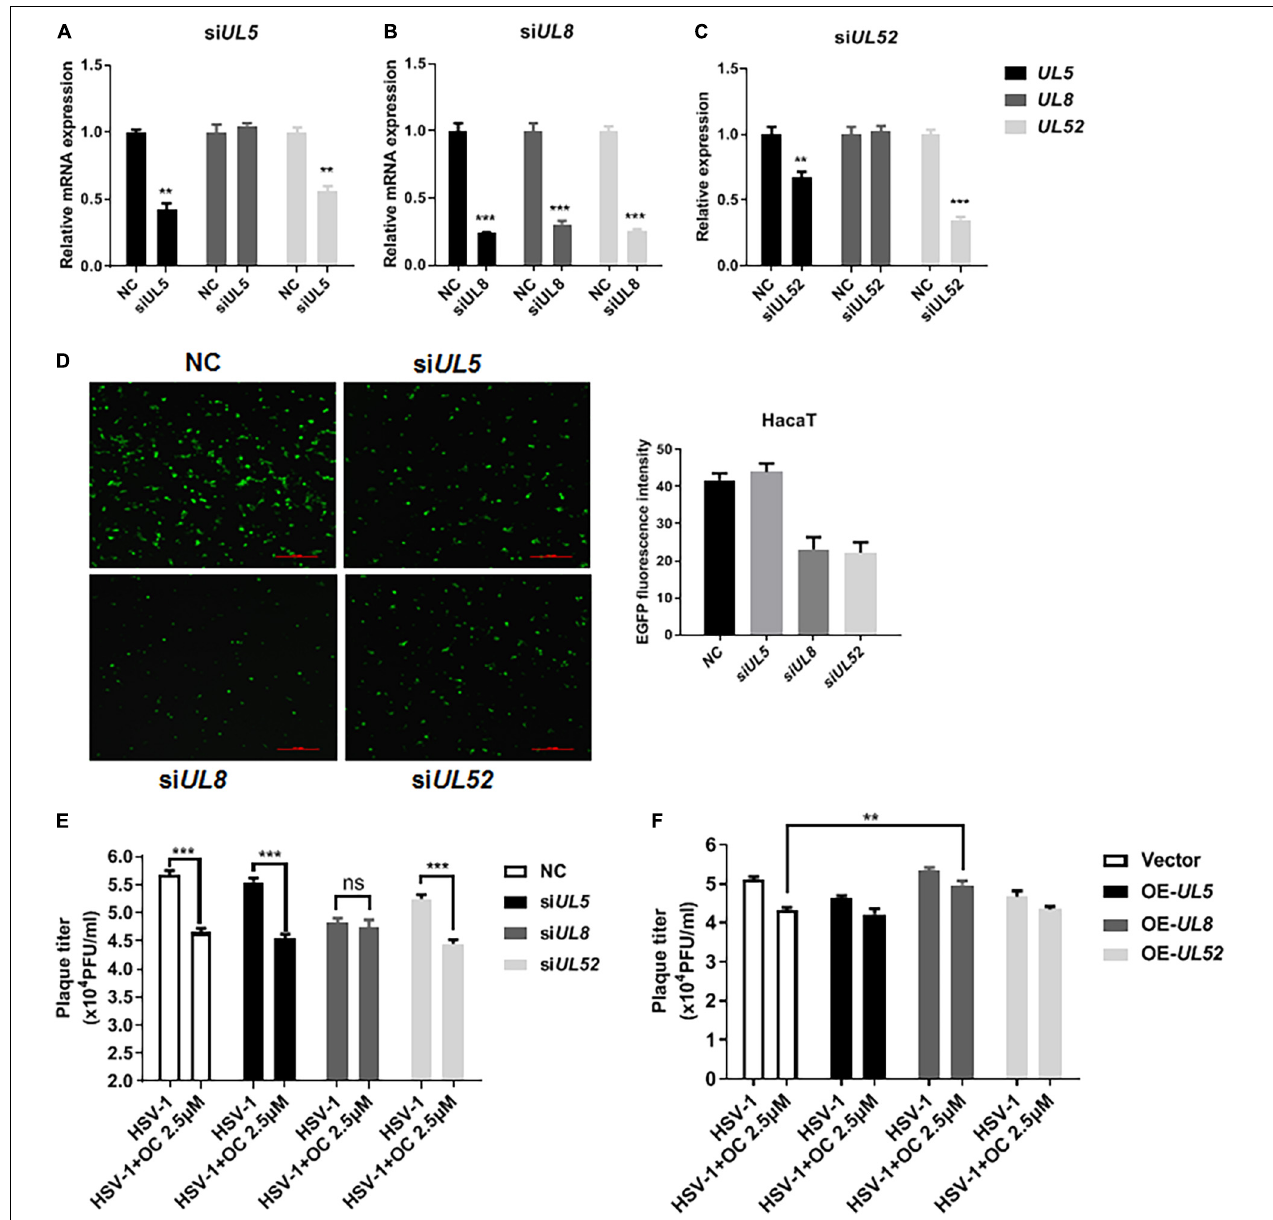
FIGURE 5 | UL8 is involved in the antiviral action of Oleanolic acid. (A–C) HaCaT cells were firstly infected with HSV-1 (MOI = 1) for 2 h and were then transfected with siRNAs targeting UL5 , UL8, and UL52 , respectively. After 24 h incubation, total RNA was extracted and the mRNA expressions of UL5 , UL8, and UL52 were detected by qRT-PCR. (D) HaCaT cells were infected with the EGFP-HSV-1 strain in the presence of different siRNAs for 24 h. The cells were then fixed and immunofluorescence images were taken under a fluorescence microscope. The fluorescence intensity was determined by ImageJ. (E) HaCaT cells were firstly infected with HSV-1 (MOI = 1) for 2 h and were then transfected with siRNAs for 24 h. The cells were then treated with Oleanolic acid (20 µ M) for another 24 h. The supernatant and cell pellets were frozen at − 80 ◦ C and thawed three times, diluted into different concentration gradients and added into the Vero cells in 96-well plate. The CPE effect was observed and the viral titer TCID 50 was calculated. (F) HaCaT cells were transfected with overexpression-plasmid UL5 , UL8, and UL52 at 37 ◦ C for 24 h, respectively. The cells were then challenged with HSV-1 (MOI = 1) and Oleanolic acid (20 µ M) for another 24 h. The supernatant and cell pellets were collected and viral titer was calculated. Data are mean ± SD ( n = 3). ** p < 0.01, *** p < 0.001. ns, not